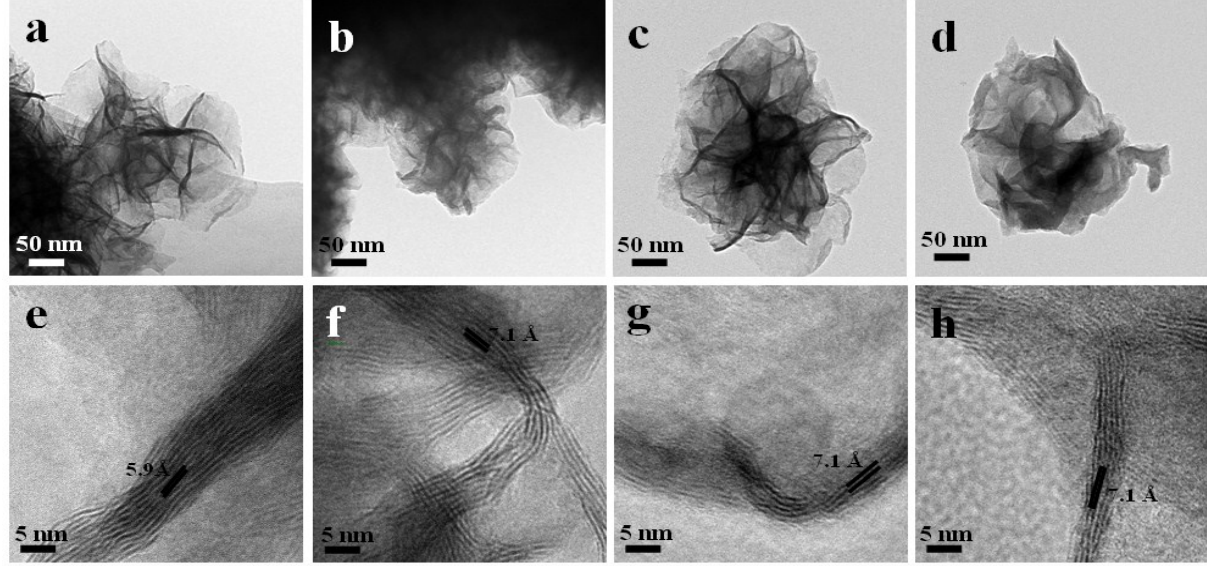
Figure 6. Transmission electron microscopy (TEM) ( a – d ) and high resolution transmission electron microscopy (HR-TEM) ( e – h ) of the various samples, represented for pure MoS 2 , MoS 2 /PVA–0.04, MoS 2 /PVP–0.08, and MoS 2 /PEI–0.04